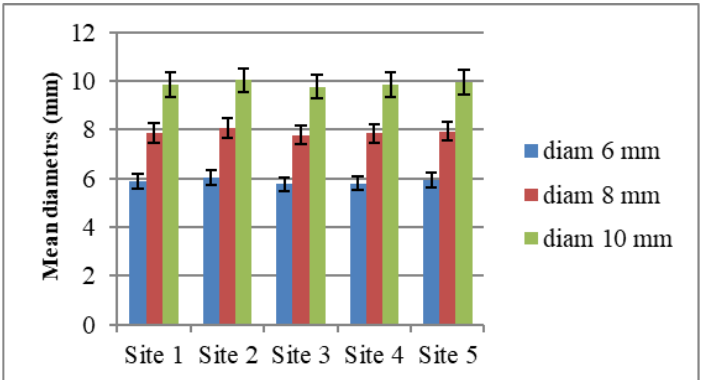
Figure 6. Mean diameter values for tests parts built using different 3D printers, materials and slicing software.